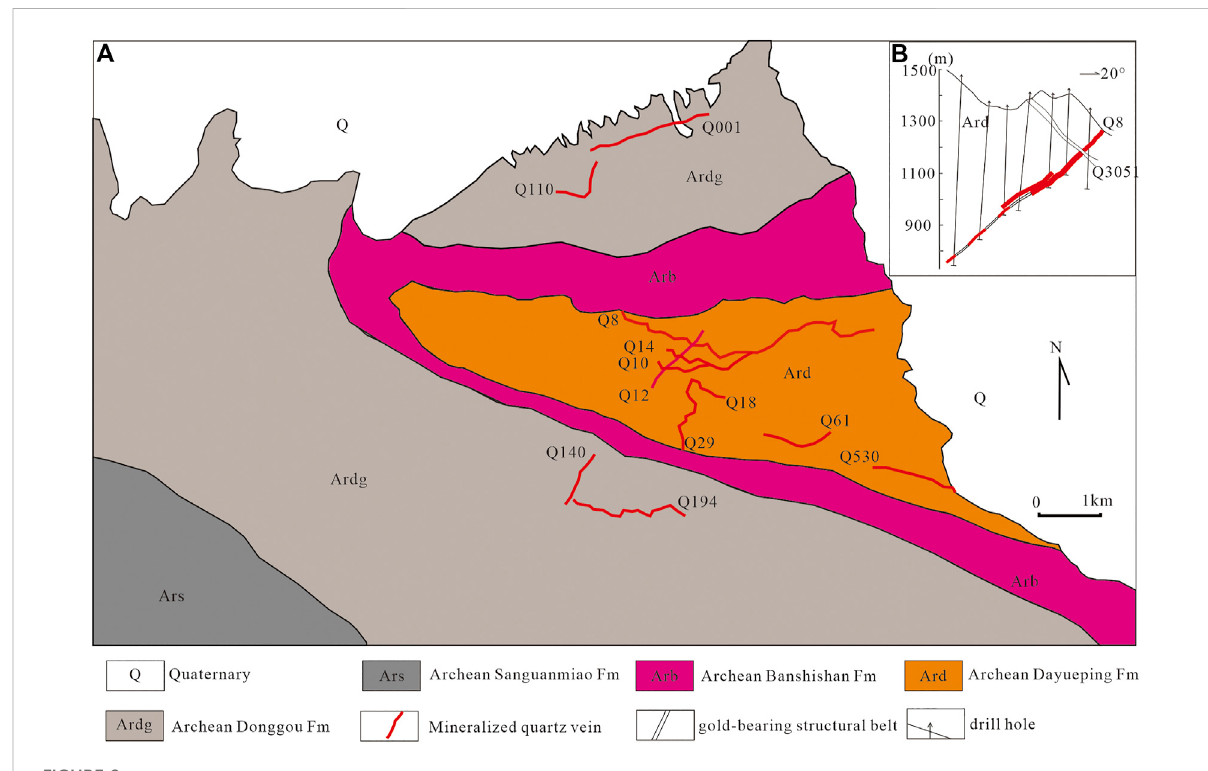
FIGURE 2 Geologicalsketchmapand cross section for theAu-bearingquartzvein; (A) -Geological sketchmapof theDongtongyugolddeposit(modi fi ed after 1: 10000 geological map by the Dongtongyu Gold Ore fi eld, Tongguan China Gold Mining Co., Ltd.); (B) -cross section (line XVII) for the Au- bearing quartz vein (modi fi ed after Bai,